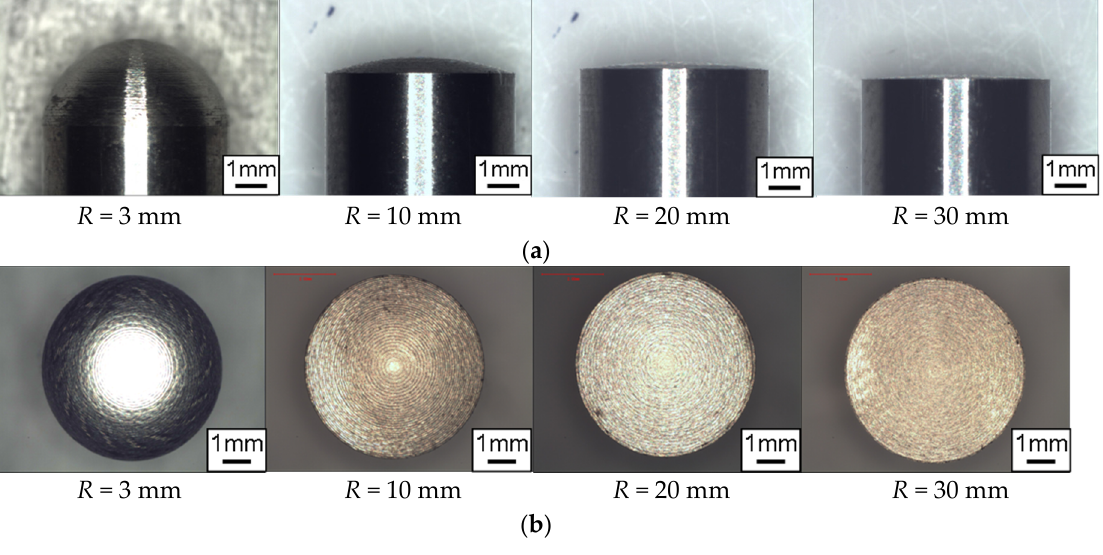
Figure 4. Tip shape of tool: ( a ) Side view; ( b ) Over top view. Table 1. Specification of burnishing tool.